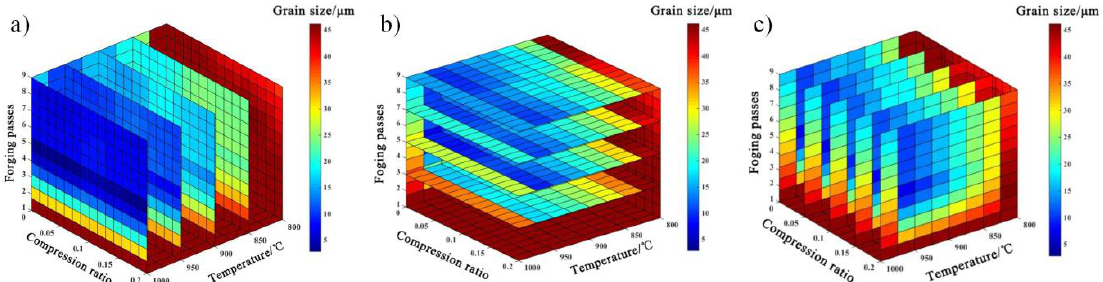
Figure 9. Grain size distribution of forgings under different forging processes: ( a ) CMDF, ( b ) single-open MDF, and ( c ) double-open MDF.